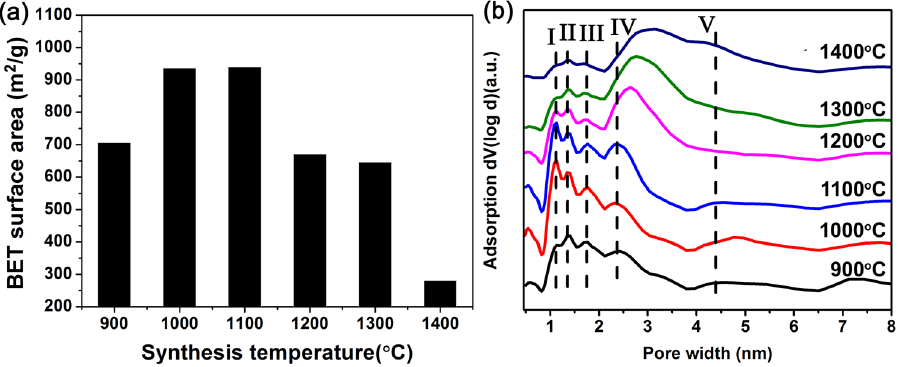
Figure 5. ( a ) The BET specific surface areas of porous BN prepared at different calcination temperatures. ( b ) The corresponding pore size distributions of the